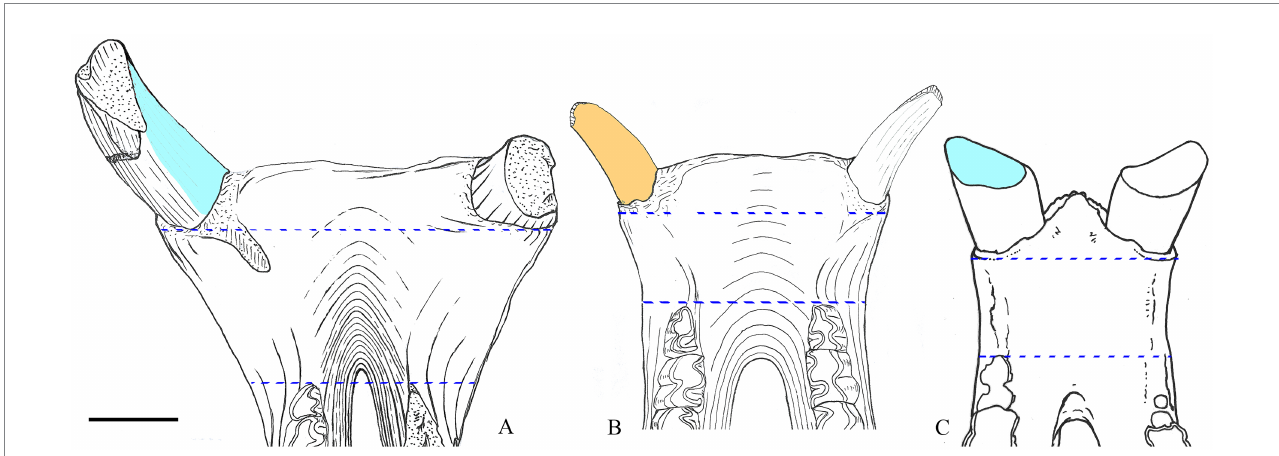
FIGURE 4 Lower incisors i2 of rhinocerotids. (A) Aprotodon lanzhouensis , IVPP V 11060, based on a specimen by Qiu and Xie (1997). (B) Chilotherium wimani , IVPP V 12505, based on a specimen by Deng (2001). (C) Rhinoceros unicornis , IVPP OV 1383, new specimen. Blue dash lines mark the width of symphysis, sky blue areas mark the occlusal surface for upper incisor I1, and the orange areas mark the surface wear with the upper lip when I1 was lost. Scale